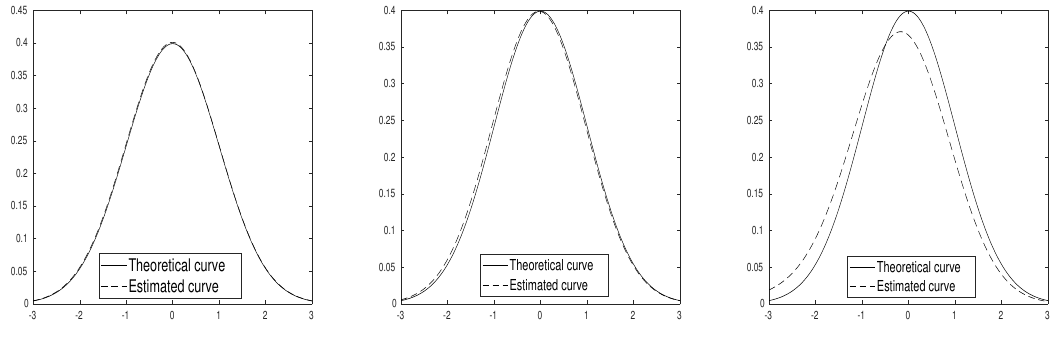
Figure 3: n = 200 and ρ = 0.6 for CR ≈ 18, 54 and 80%